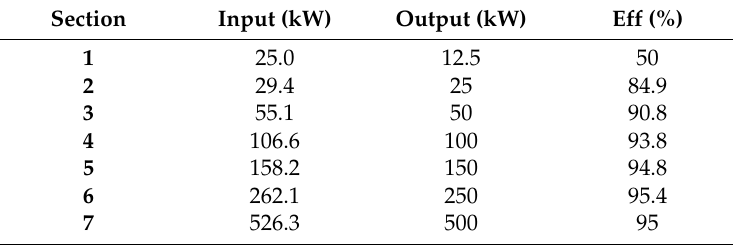
Figure 1. Types of input/output-efficiency characteristic curve of 500kW power conditioning system (PCS). Table 1. Input, output, efficiency for each section of a 500kW power conditioning system (PCS).